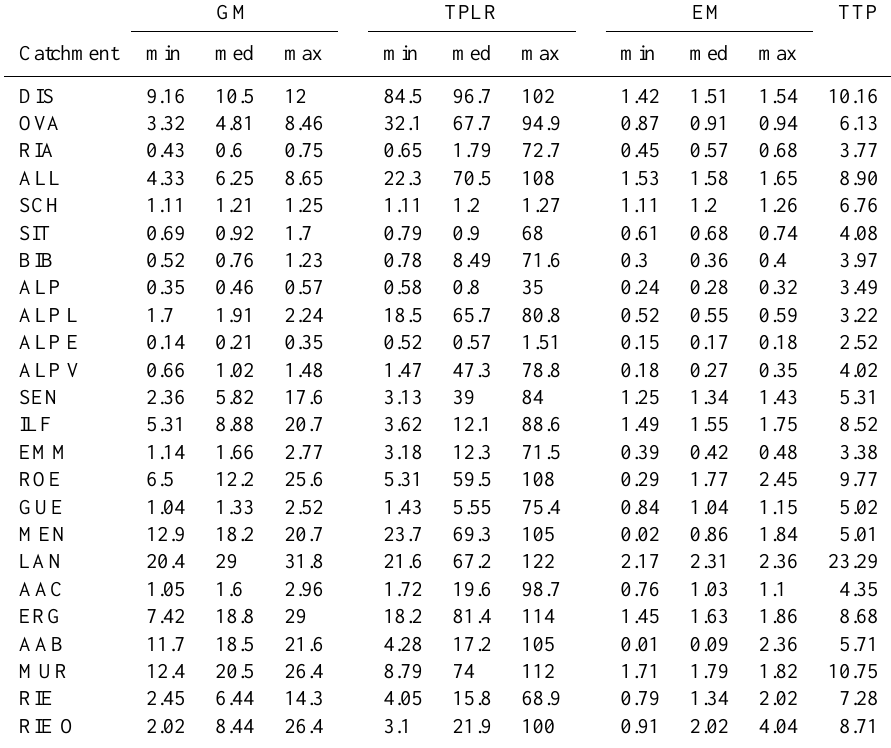
Table 5. Minimum, median and maximum MTT in years for each catchment and TF type and the respective TTP values. GM TPLR EM